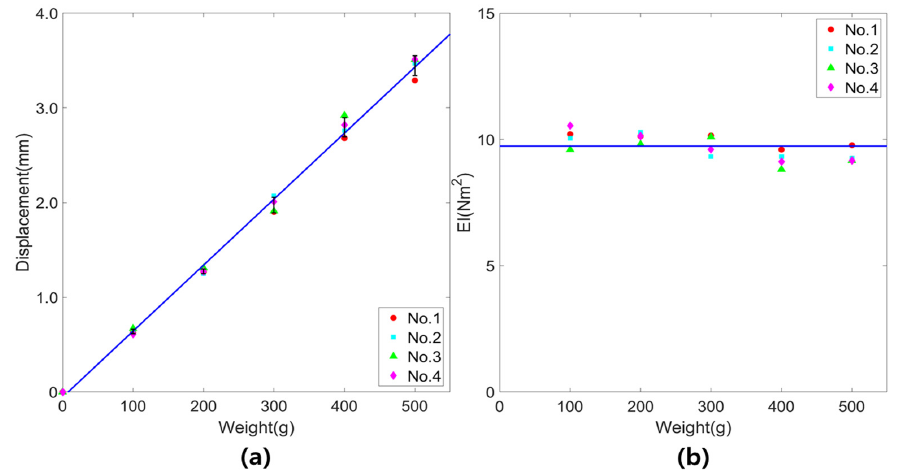
Figure 7. Static bending test results for HF-CO: ( a ) Free end displacement versus applied load (coefficient of determination: 0.998); ( b ) Equivalent flexural rigidity.